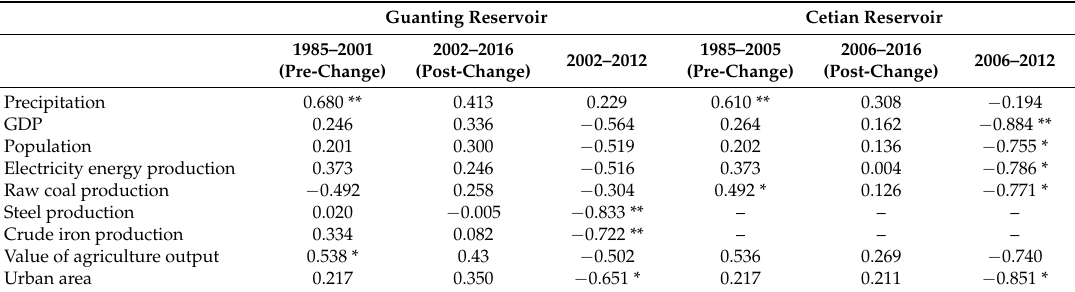
Table 5. Pearson correlation coefficients between water extents and precipitation & human activity factors in Guanting reservoir and Cetian